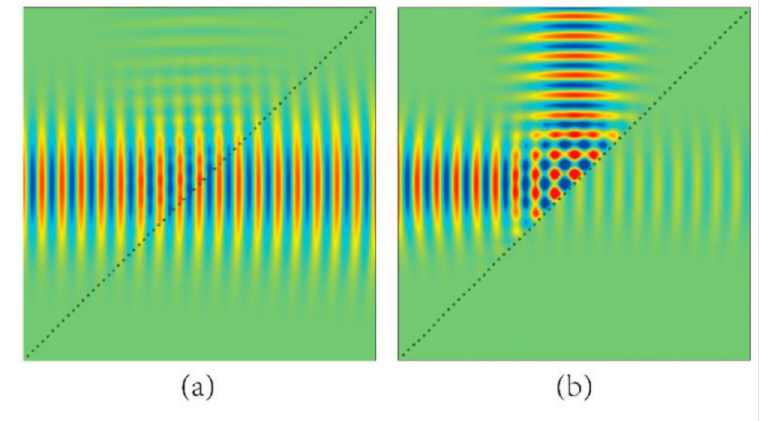
Figure 9. Electric field distribution of the incident wave when the linear polarization direction of the EM waves is perpendicular ( a ) and parallel ( b ) to the cylindrical wire array plane.